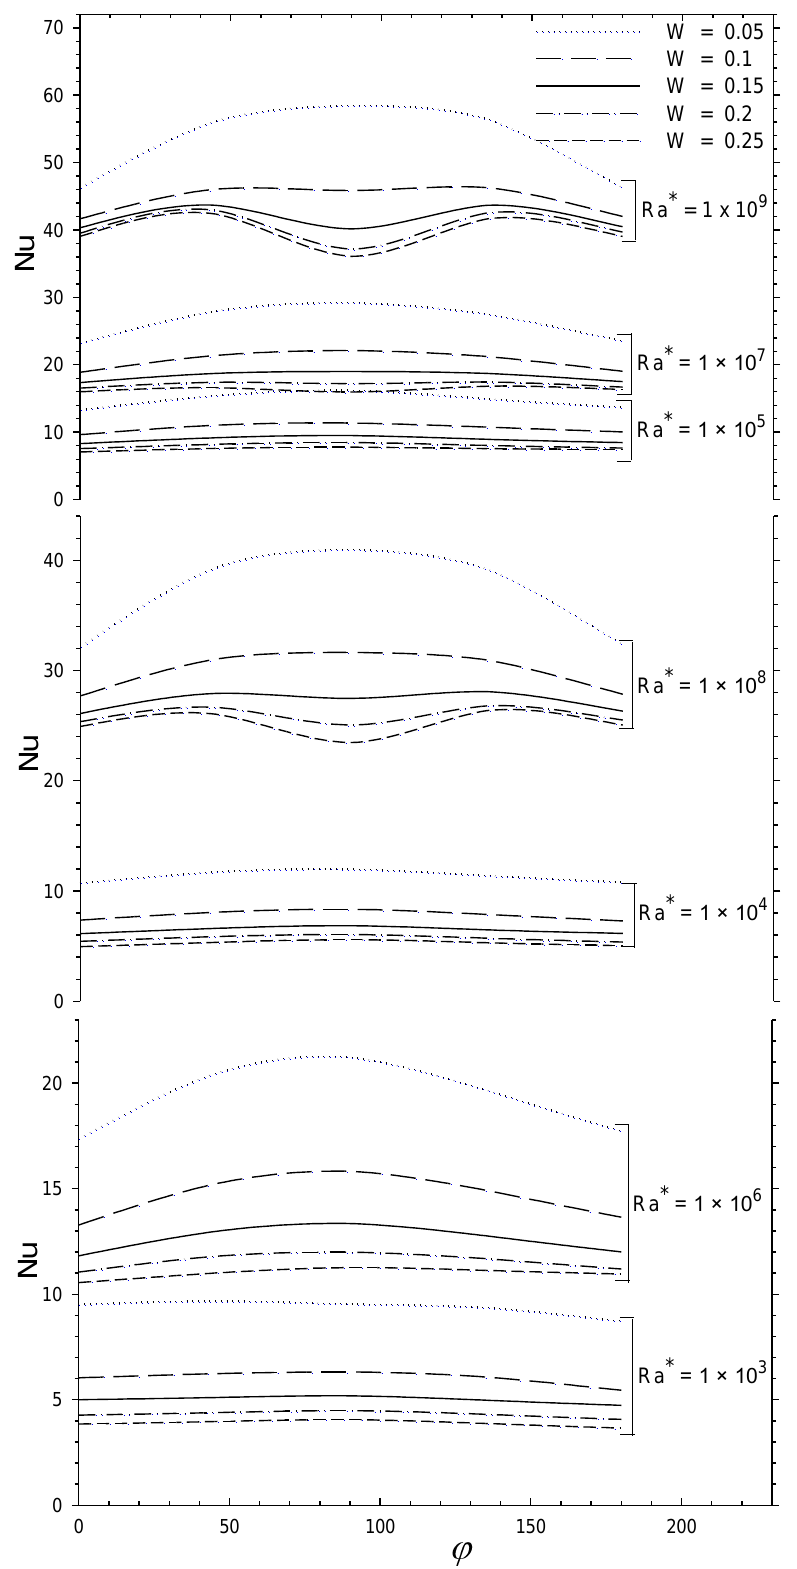
Figure 10. Variations in the mean Nusselt number for a slender cuboid with inclination ϕ for different Ra * and W .